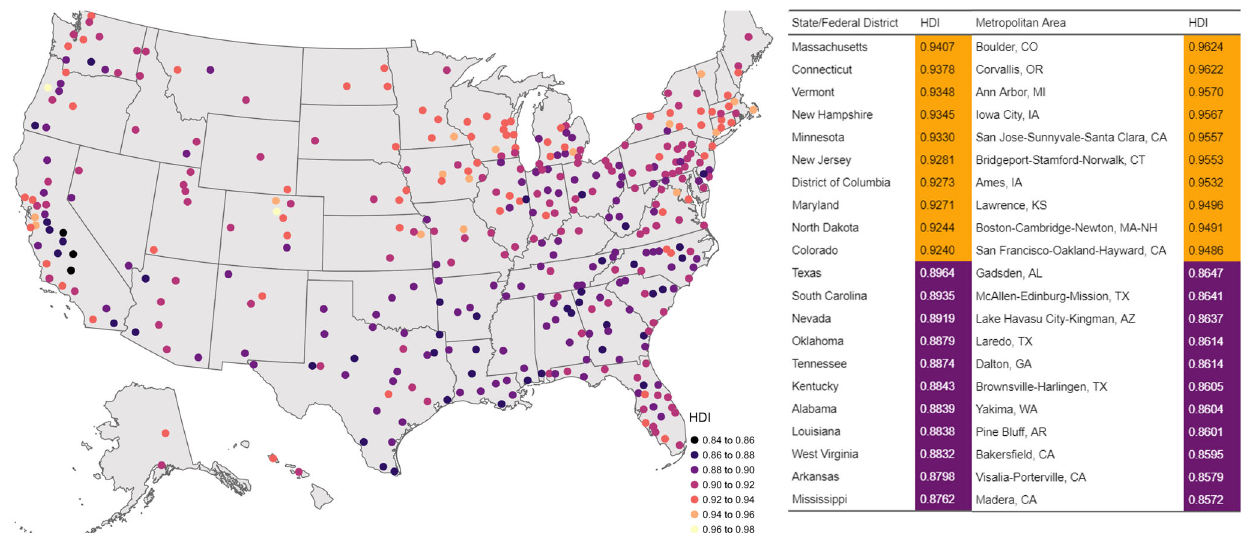
Fig. 2 Human Development in US States and Metropolitan Areas. Mapping the HDI of different metropolitan areas (left), allows us to observe which places lead solutions that promote greater human capabilities, and which lag. The differences can be ranked, with the top and bottom States and Metropolitan Areas shown on the right. States and cities with larger public efforts in education, healthcare and innovation tend to be leaders. This pattern is clearer at the city level where “ college towns ” and urban areas with higher concentrations of education and research top HDI rankings, regardless of geography even in lower performing states. The top HDI micropolitan area is Los Alamos,